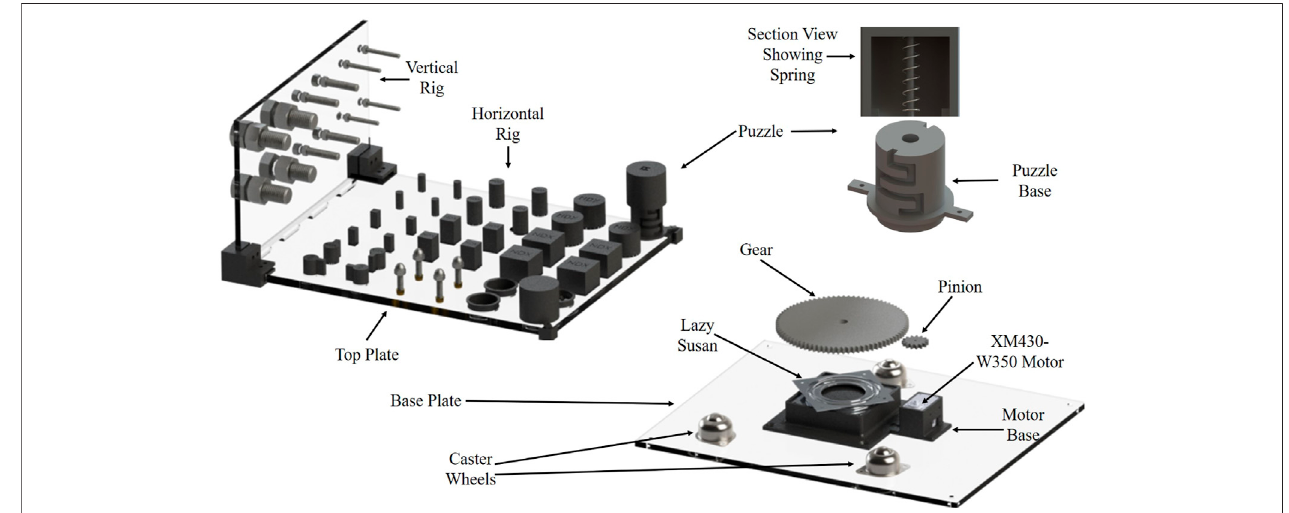
FIGURE 2 | Exploded view of the proposed dexterity test board.